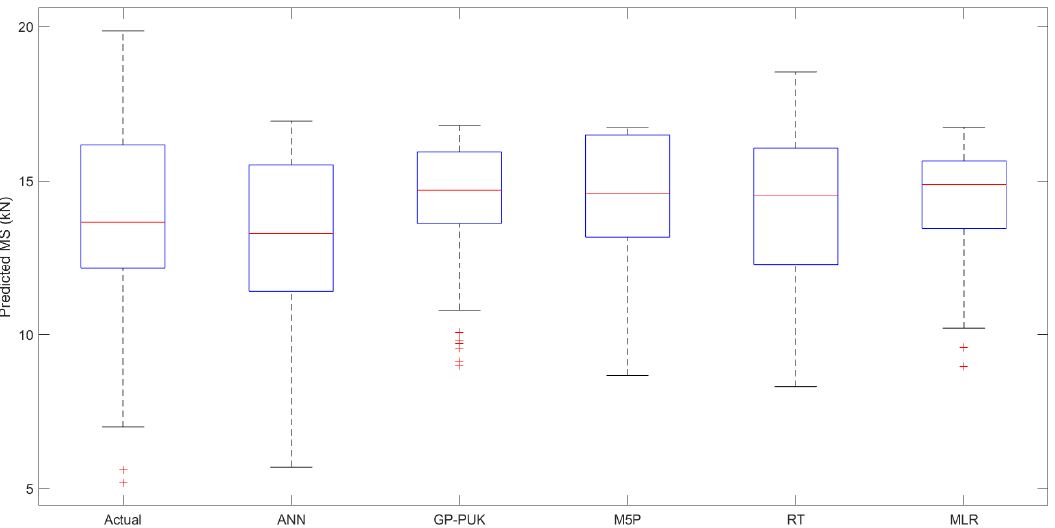
Figure 10. ( a , b ) Comparison of all models using training and testing stages.